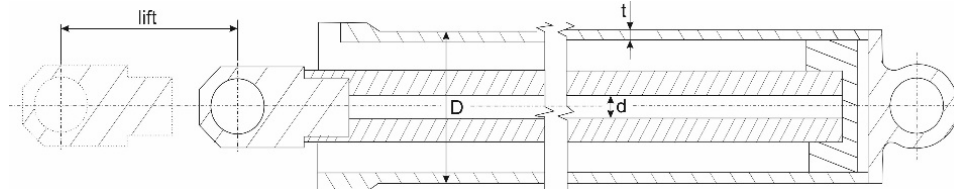
Figure 1. Basic dimensions of hydraulic cylinders.